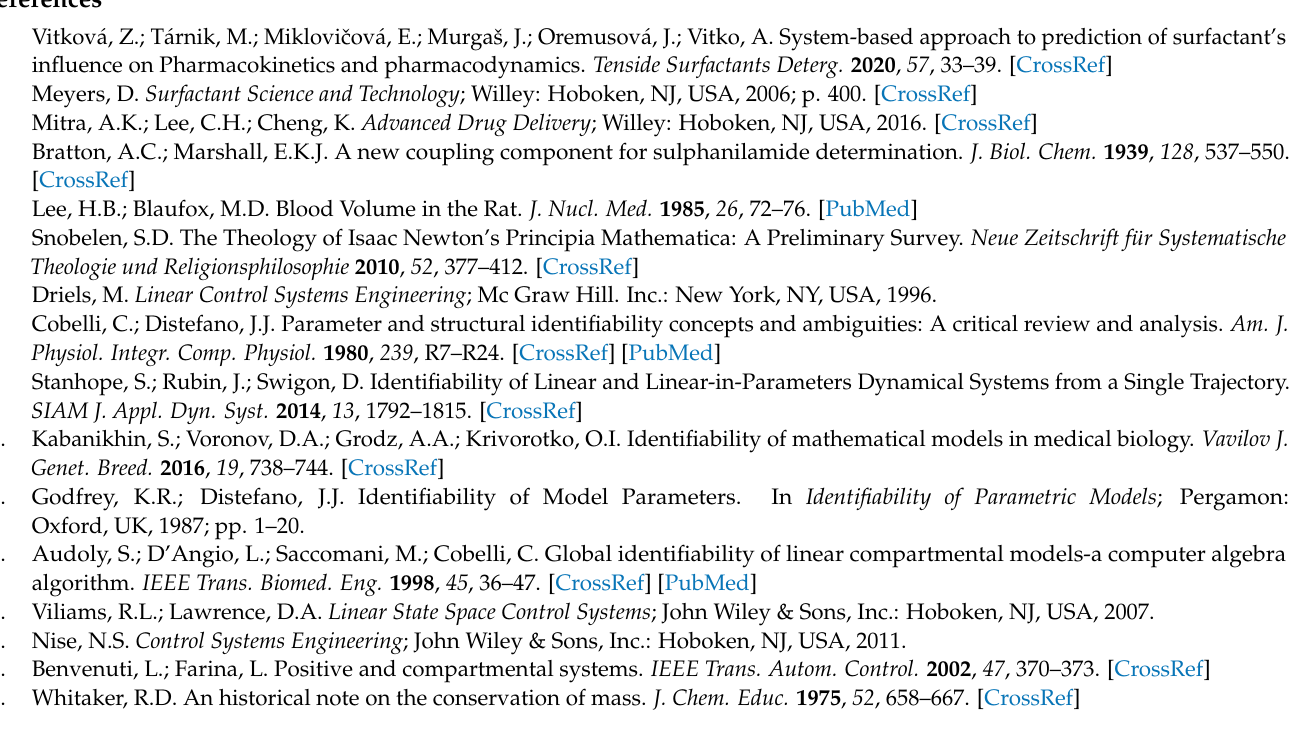
Applying the same procedure on the samples containing the tenside (samples M in Table 1) the model (A1) produced the following triples of the parameter values: ( k 12 = 0.045817, k 21 = 0.943229, k e = 0.258784) or (A3) ( k 12 = 0.045817, k 21 = 0.258784, k e = 0.943229) Clearly, values of k 12 , ( which is in essence the absorption rate constant k a ) obtained before and after additions of the tenside are exactly the same for both models (6) and (A1). Specifically, k a = 0.030272 h − 1 before addition and k a = 0.045817 after addition of the tenside. These results also confirm that absence of the full parametric identifiability may not preclude the correctness of the